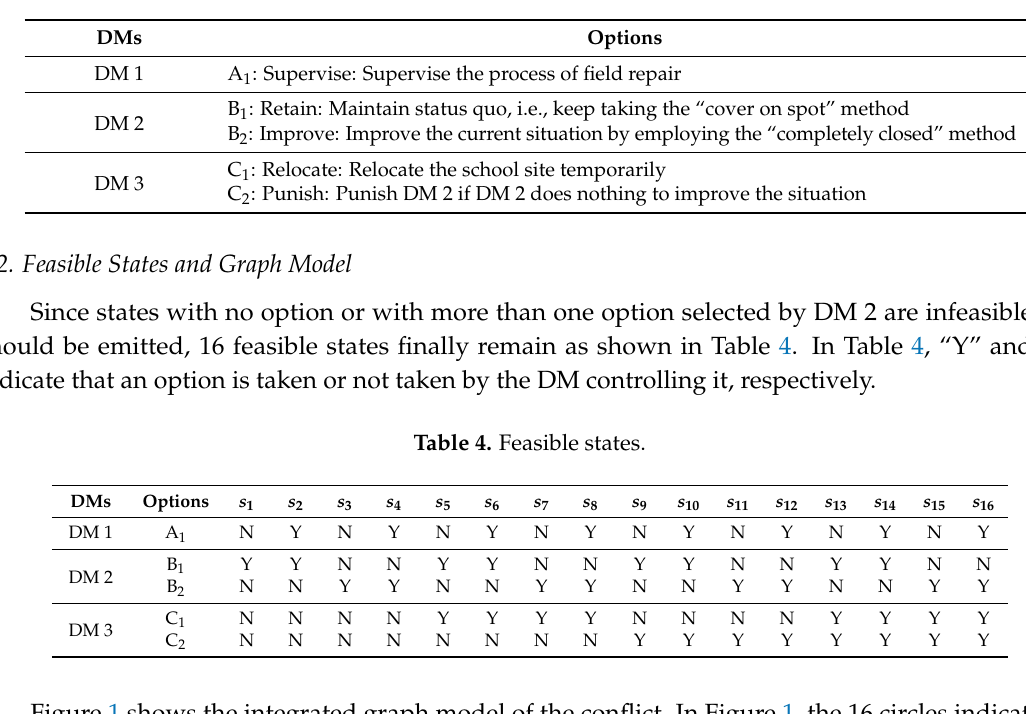
Table 3. DMs and options.